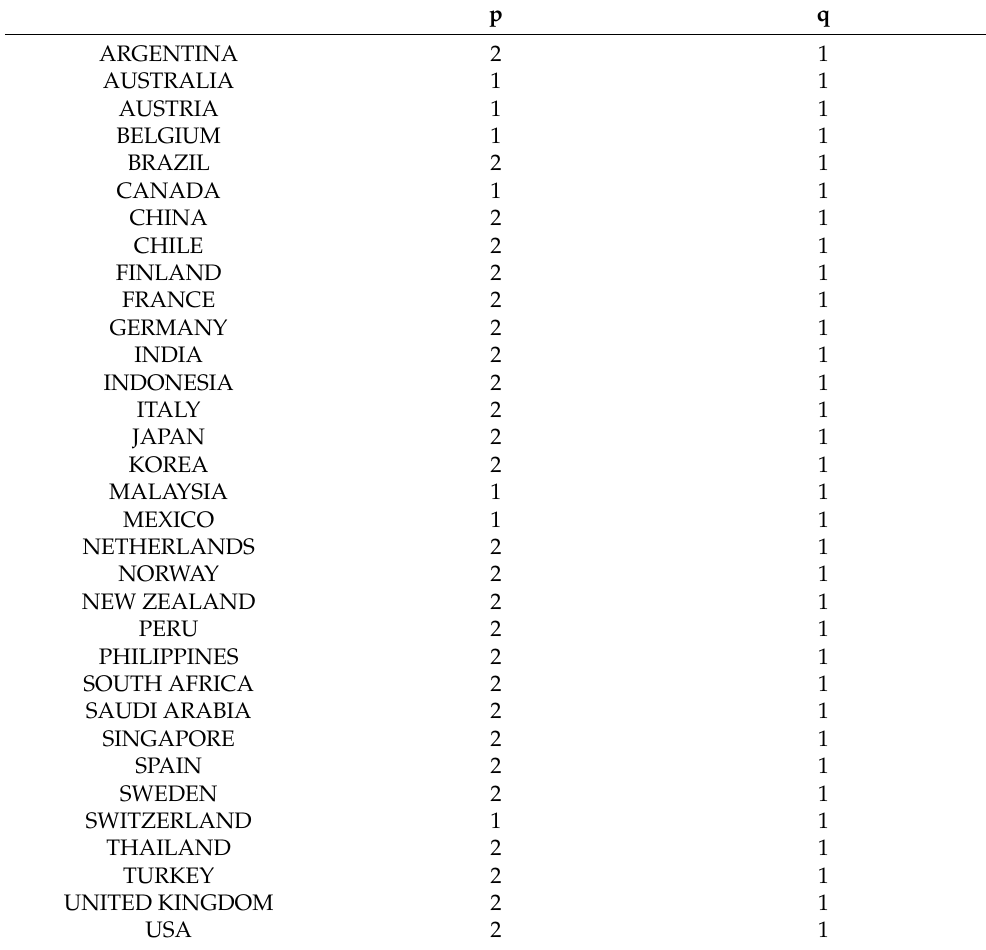
Table A1. VARX* Order of individual models p = lag order of domestic variables, q = lag order of foreign